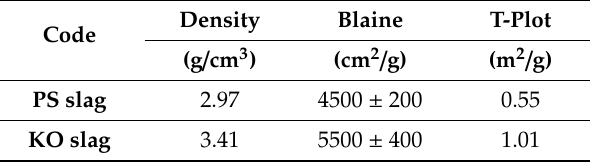
Table 4. Precursors’ density and specific surface area measured by Blaine and NAD